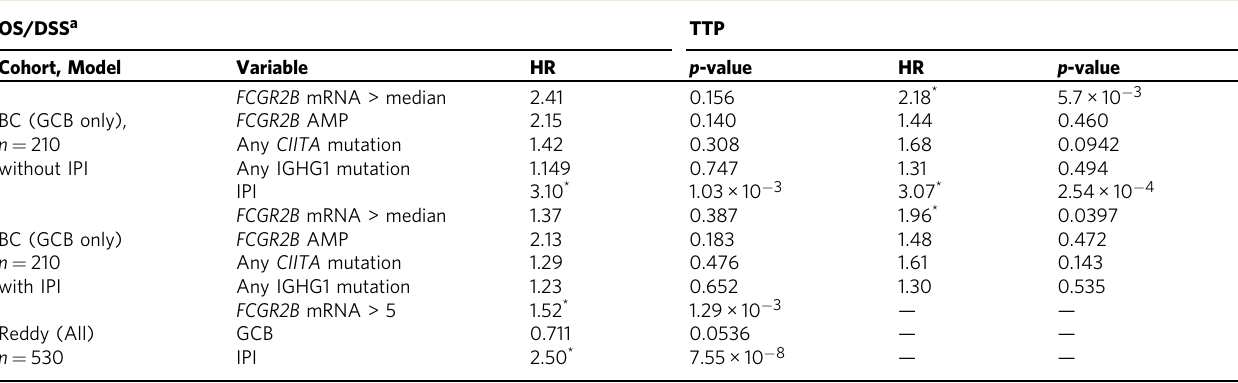
Table 2 Multivariate analysis of FCGR2B expression on disease-speci fi c survival and time to progression OS/DSS a TTP Cohort, Model Variable BC (GCB